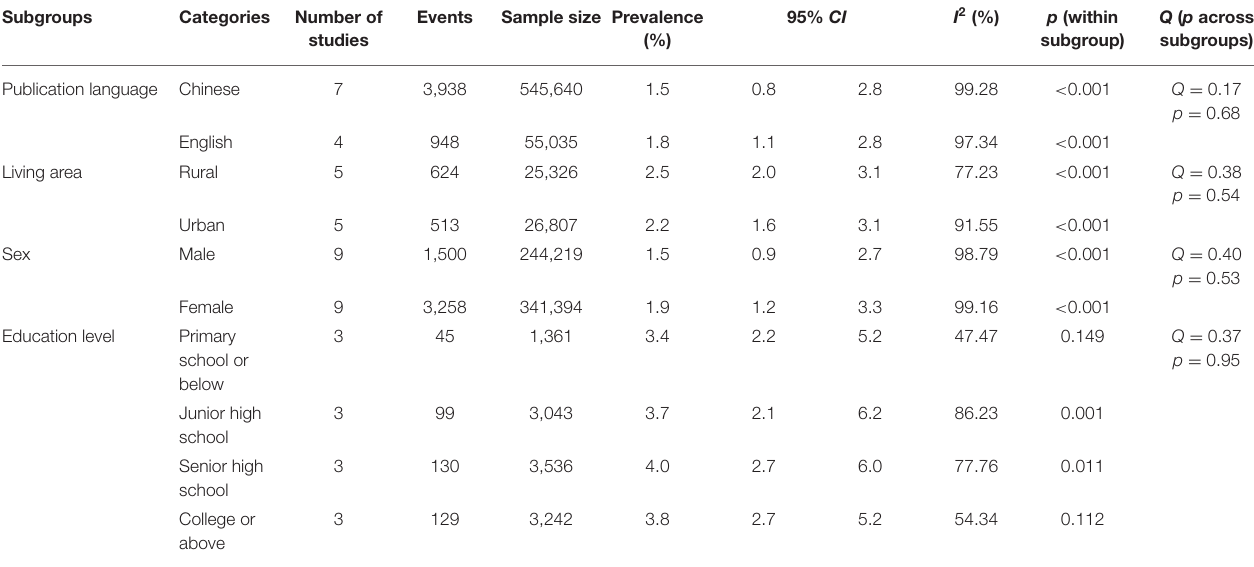
TABLE 4 | Subgroup analyses of 12-month prevalence of MDD in China. Subgroups